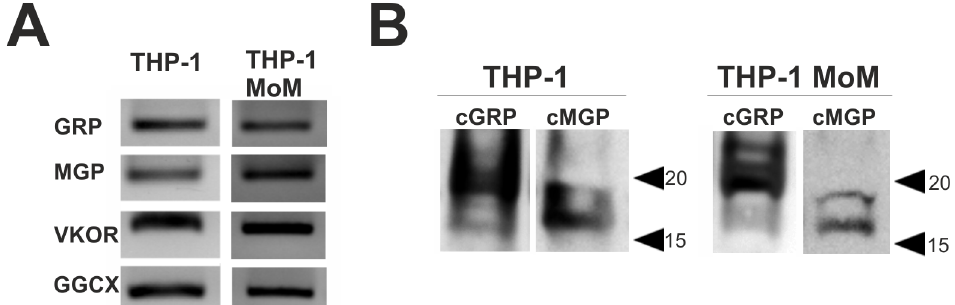
Fig 2. γ -carboxylatedGRP and MGPareproduced in THP-1cell line. THP-1andTHP-1MoMdifferentiated with25ng/mlof PMA during48hwereculturedin controlconditions andharvestedfor RNAandproteinextraction. (A) Qualitative geneexpression analysisof GRP, MGP, VKORandGGCX byRT-PCRin undifferentiatedTHP-1 representing monocyte cells(THP-1),andindifferentiatedTHP-1representingmacrophages(THP-1MoM).(B) Westernblotanalysisof thirty μ gof total RIPAproteinextractsof THP-1andTHP-1MoMcellsusingthe con- formation-specificantibodiesrecognizing γ -carboxylatedGRP(cGRP) andMGP (cMGP). Position of